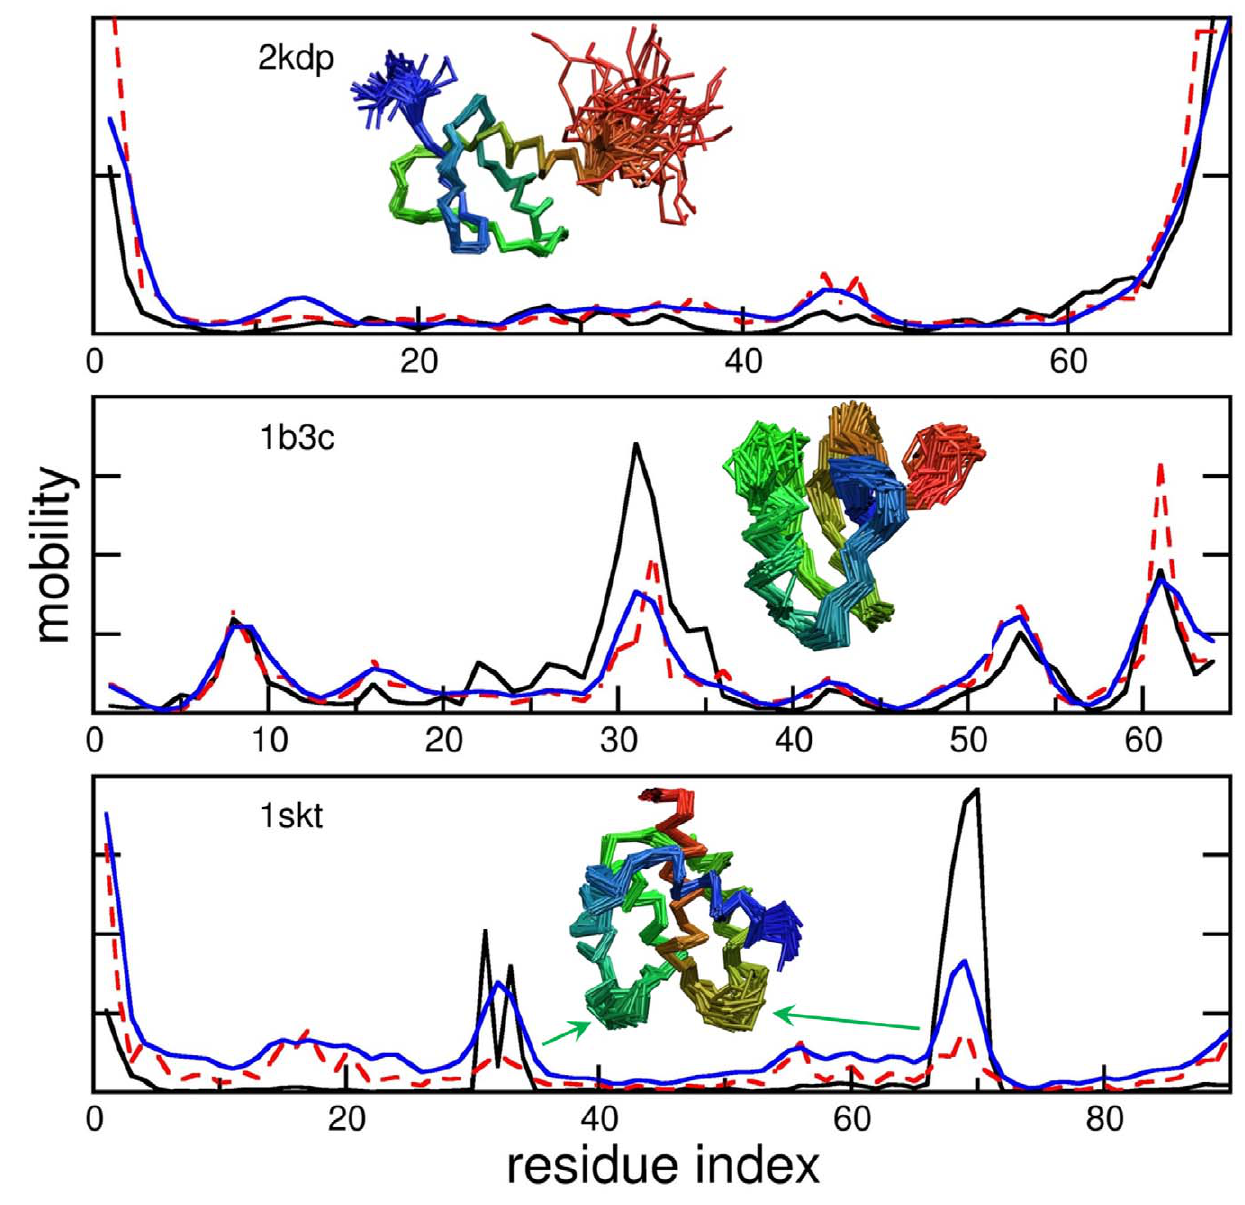
Figure 3. GNM-predicted motions display a range of overlaps with observed mobilities. The panels display the mobility profiles for three example proteins from our test set to illustrate the various levels of agreement observed between theory and experiments. The curves are calculated from the first five modes of the covariance matrix deduced from NMR experiments (solid black lines), the five slowest GNM modes (dashed red lines) and the five slowest mGNM modes (solid blue lines). Insets are cartoons of the NMR ensembles for the three proteins, colored blue to red from the N- terminus to the C-terminus. An example of good agreement between GNM and observed covariances is the histone deacetylase complex protein 2kdp (top panel), for which the GNM accurately predicts high mobility at the termini. The correlation coefficient (cc) between theory and experiments is 0.91 in this case for both GNM and mGNM, due in large part to the motion at the protein termini. Average agreement of 0.67 is seen in the scorpion neurotoxin 1b3c, for which GNM predicts excessive motion near the C-terminus and under-predicts motion of the loop around residue 32, shown in green in inset cartoon. When mGNM is used, the sharp changes in the mobility profile are smoothed and the correlation increases to 0.79. In the calcium binding protein1skt (bottom), the GNM predicts motion at the N-terminus, whereas the NMR ensemble shows higher variation around the two turns around residues 33 and 69 (green arrows). The mGNM improves agreement by increasing mobility around these turns. The correlation between theory and experiments is increased from 0.31 to 0.57 upon adopting the mGNM instead of the GNM (with uniform force